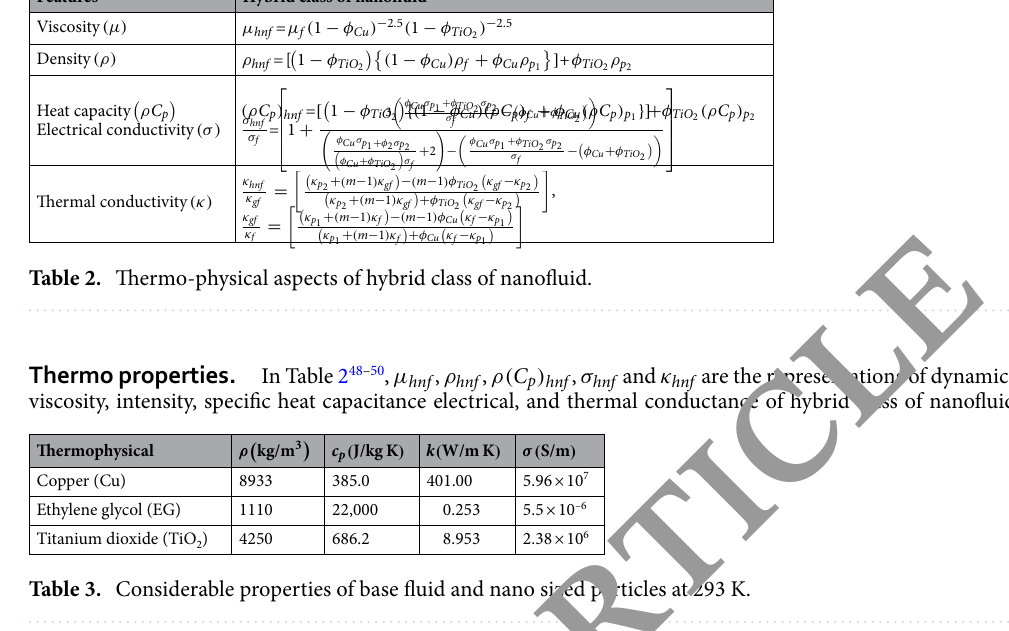
Table 4. Shape factor value for diverse particle